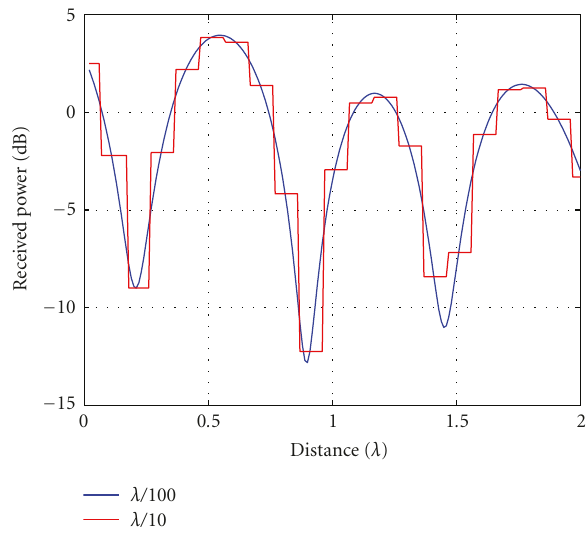
Figure 4: Fading generated from a 360 ◦ azimuth distribution.